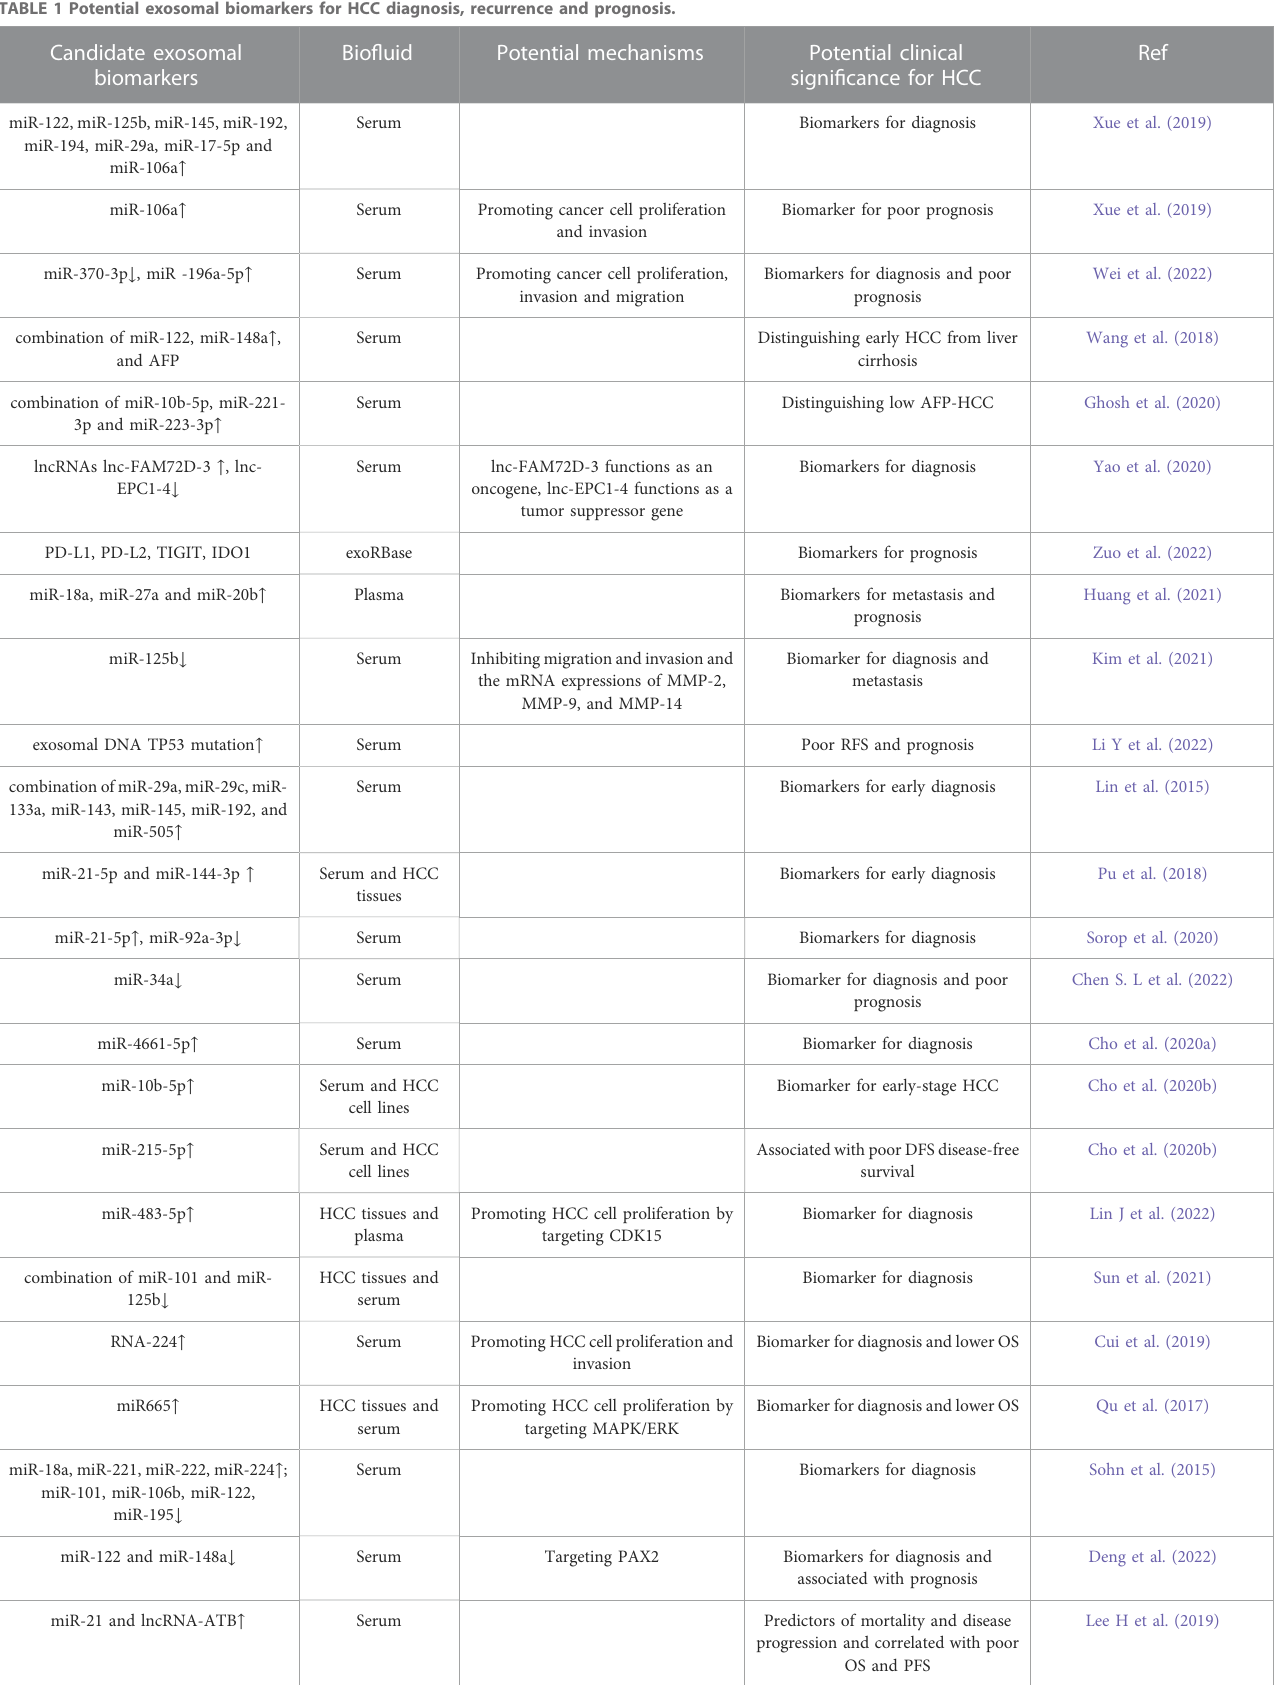
TABLE 1 Potential exosomal biomarkers for HCC diagnosis, recurrence and